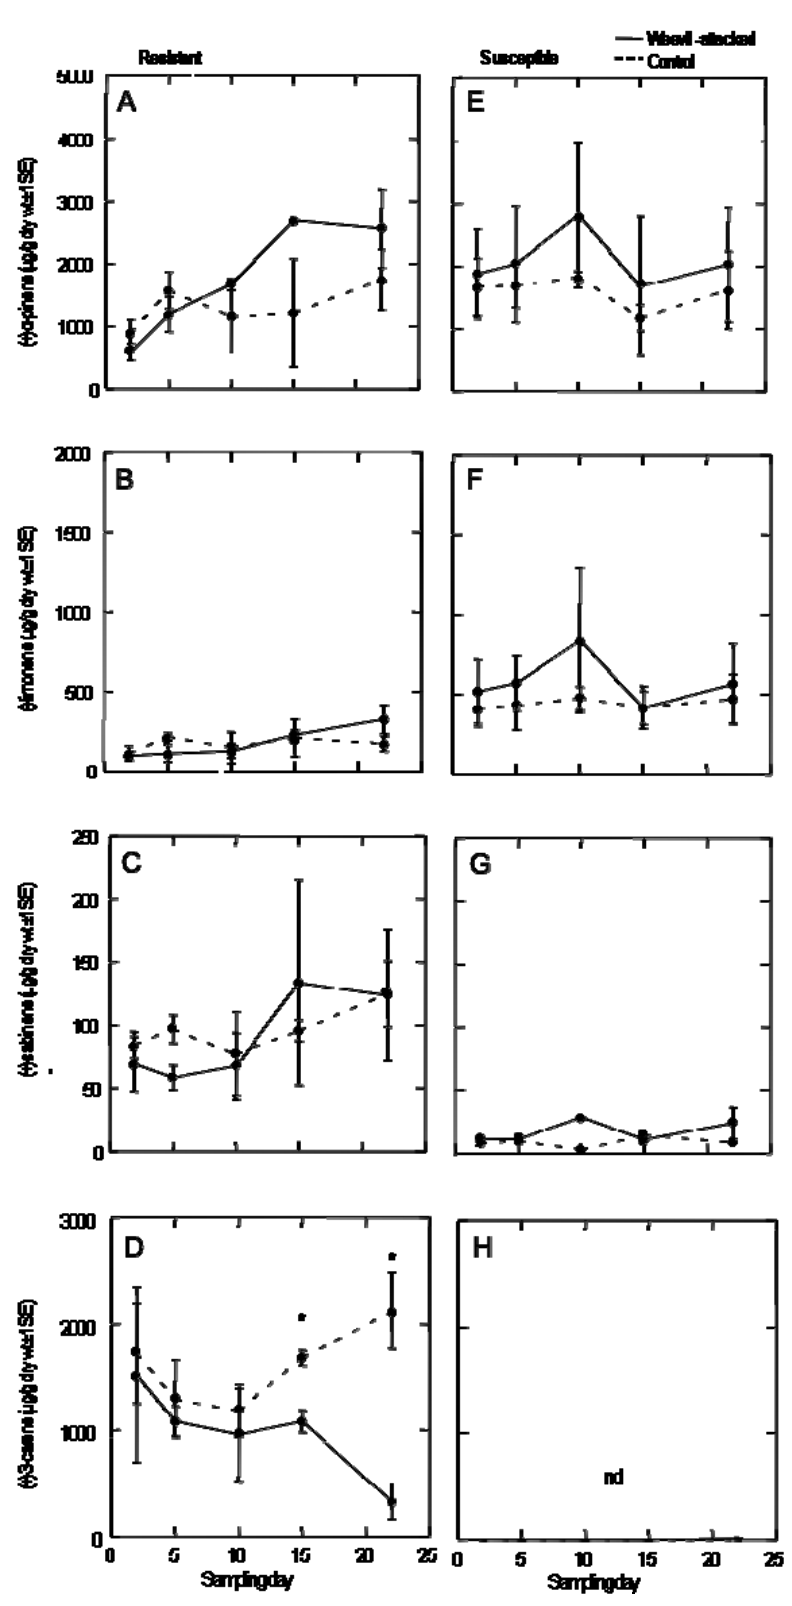
Figure 2. The resistant and susceptible monoterpene profiles in response to weevil feeding. The average amount of monoterpene measured (µg/g dry weight ± 1SE) on each sampling day for resistant (A-D) and susceptible (E-H) trees. Asterisk indicates a significant difference between treatment and control (p < 0.05). nd = not